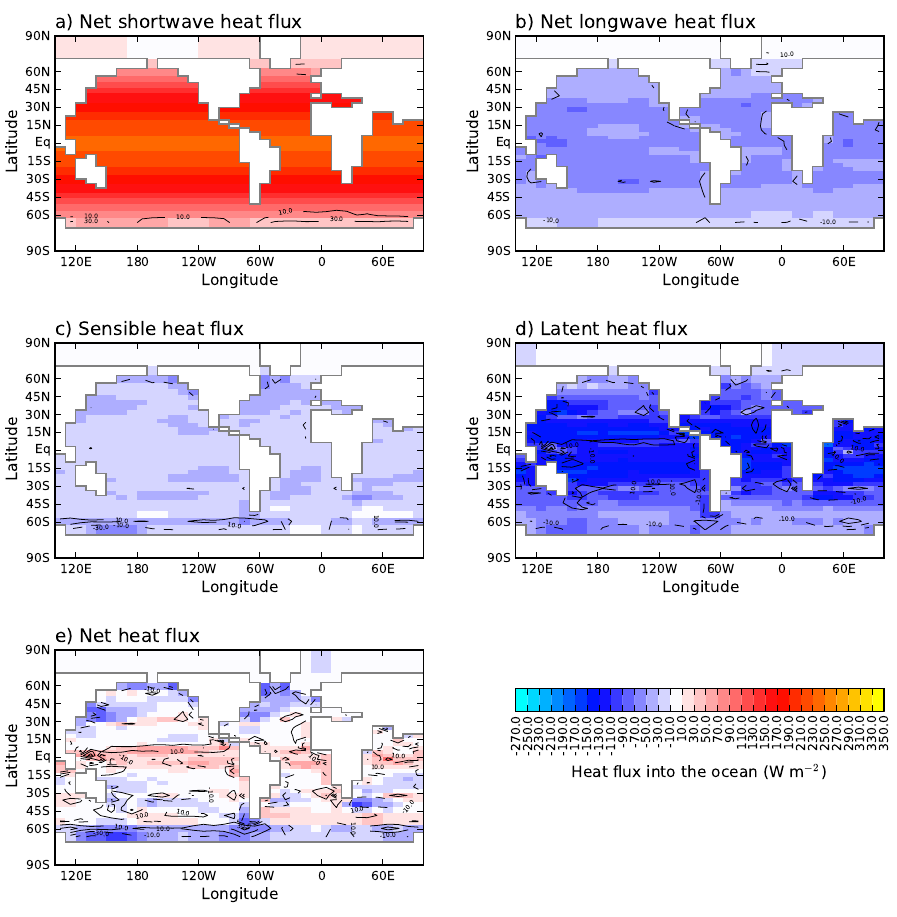
Fig. 17. Annual-mean components of surface heat flux (W m − 2 ) into the ocean for 3636s16l (maps) and “3636s16l” minus “biogem” differences